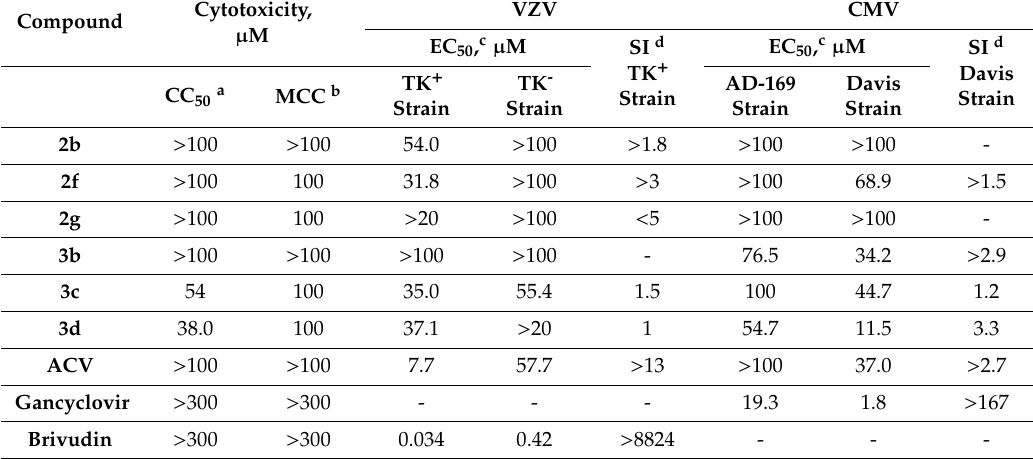
Table3. Cytotoxicityandantiviralactivityagainstvaricella-zostervirus(VZV)andhumancytomegalovirus (CMV) in HEL cells. Compound